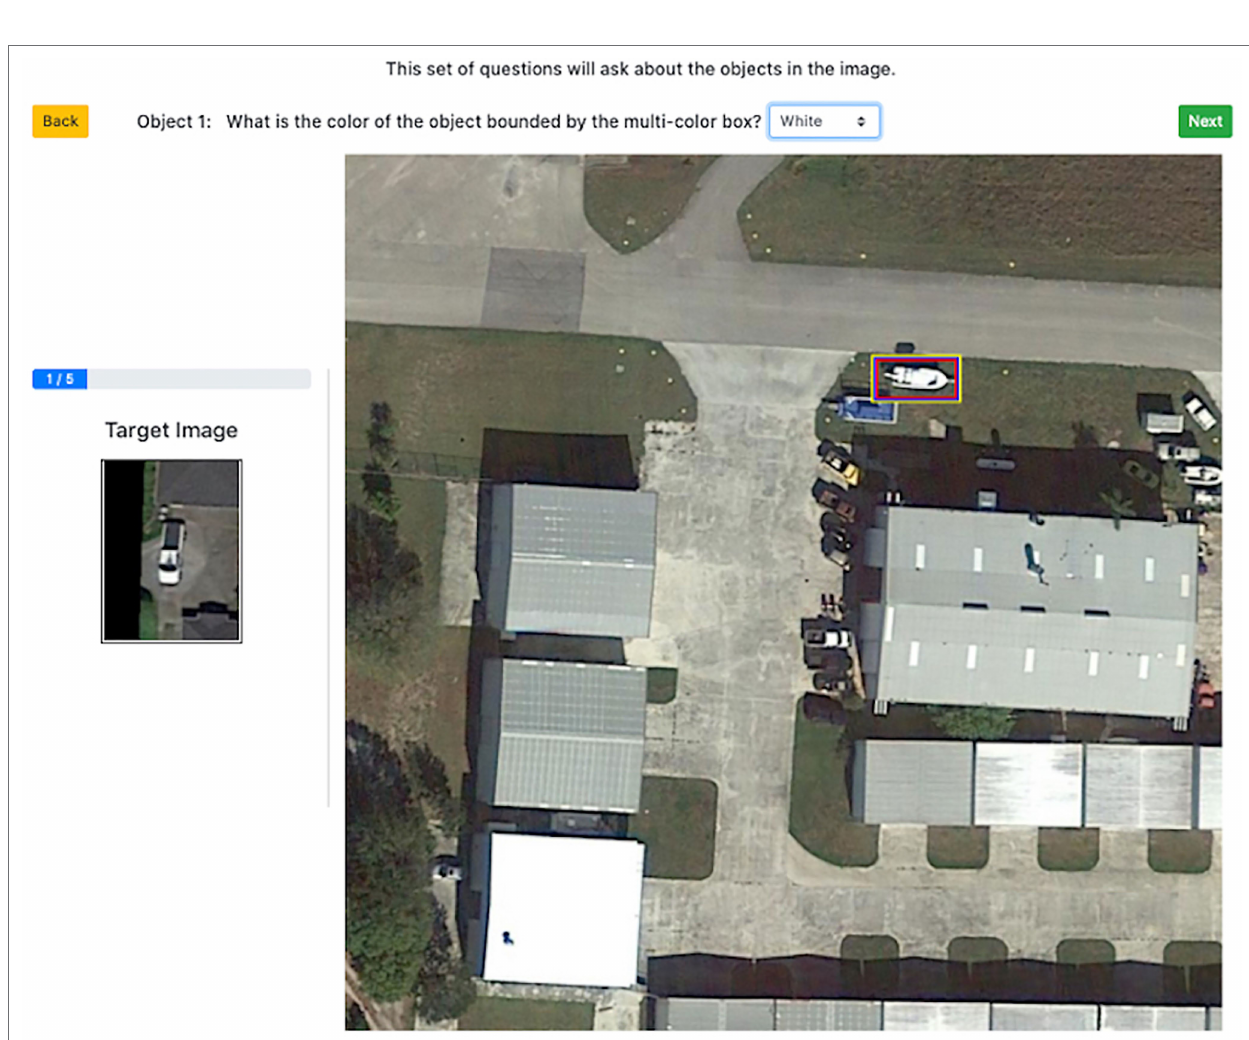
FIGURE 5 | Screenshot of instance-level color rating during Experiment 2 trial. Image provided by iSAID dataset (Zamir et al., 2019) using Google Earth images.